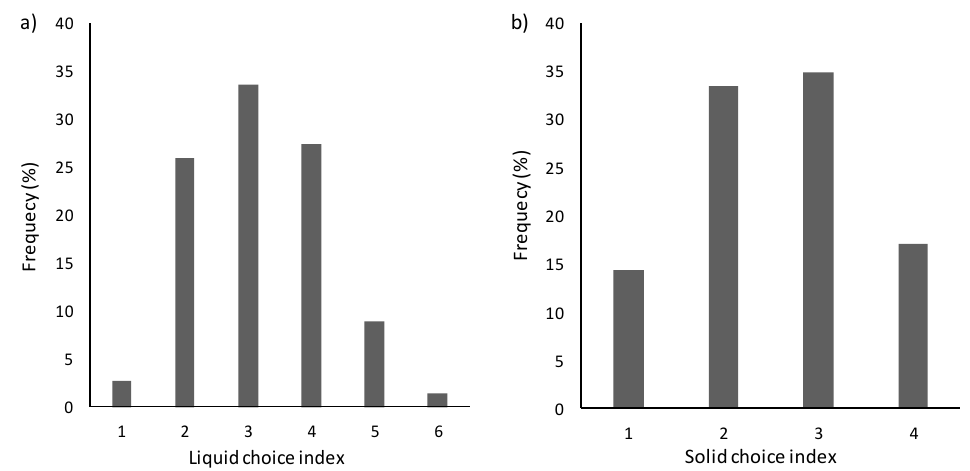
Figure 3. Choice index for the liquid domain ( a ) and the solid domain ( b ).